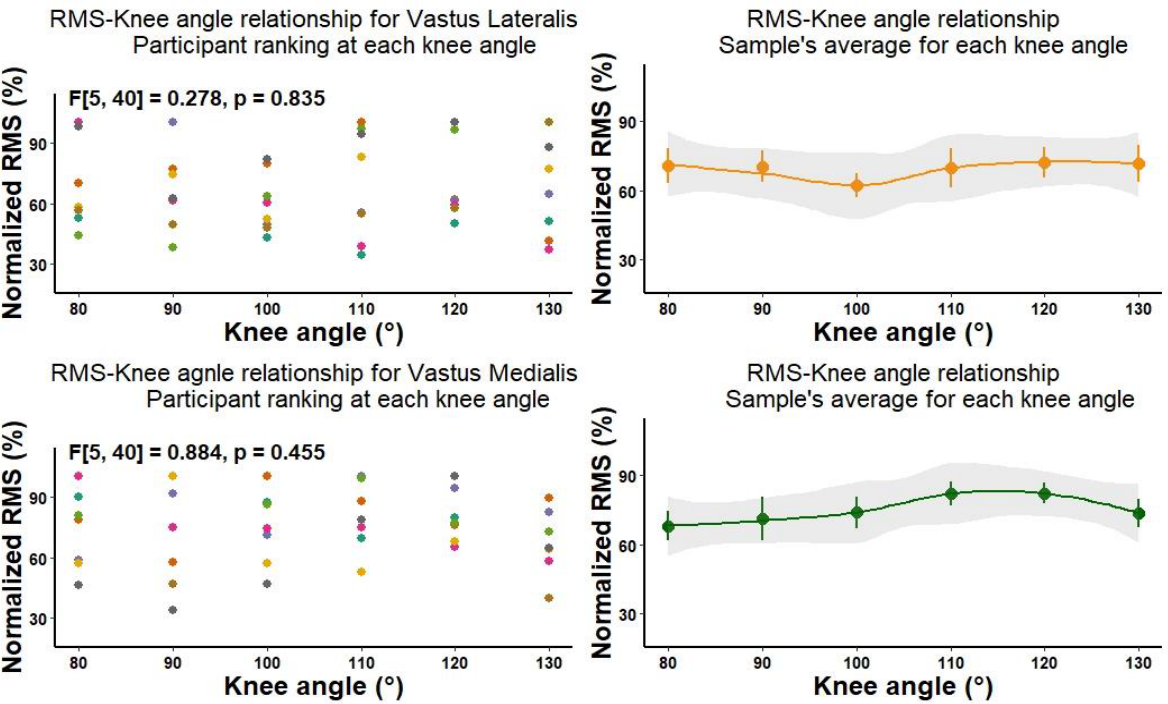
Figure 2. The effects of knee angle on muscle activation of vastus lateralis and vastus medialis. The muscle activation–torque relationship was not affected by knee angle in ∆ VM RMS (F[5] = 1.515, p = 0.251), while the non-parametric Friedman test of differences showed a significant effect of knee angle on the muscle activation – torque relationship in VL RMS (Figure 3). Pairwise comparisons showed significant differences in muscle activation – torque relationship of VL RMS in relation to knee angle. As the knee extended from 80° towards more extended knee angles (i.e., muscle shortening), the proportion of activation in produced torque gradually reduced (Table 3). A significantly lower proportion of acti- vation was found at knee angles of 100°, 110°, and 120° compared to 80° as well as at 110° compared to 90°. It is of note, however, that the effect sizes were below the level of 1.6, which G*Power determined as the level of significance. Therefore, these results could be interpreted as trends rather than the significant effects of muscle length on muscle activa- tion – torque ratio.